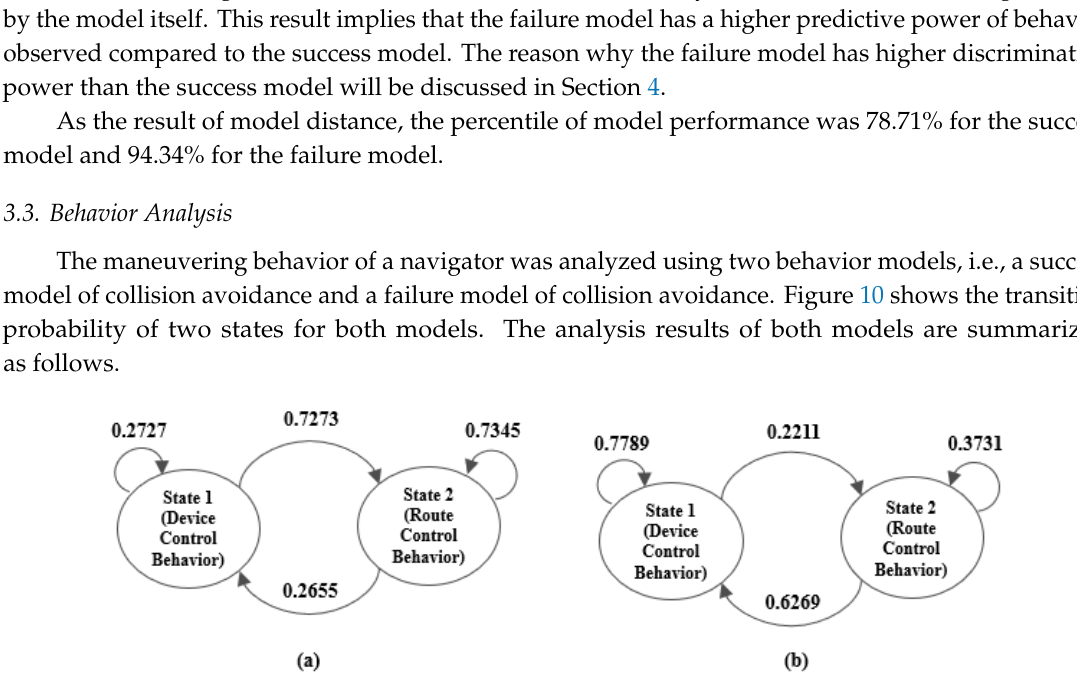
Figure 10. Maneuvering behavior models: ( a ) success of collision avoidance, and ( b ) failure of collision avoidance.